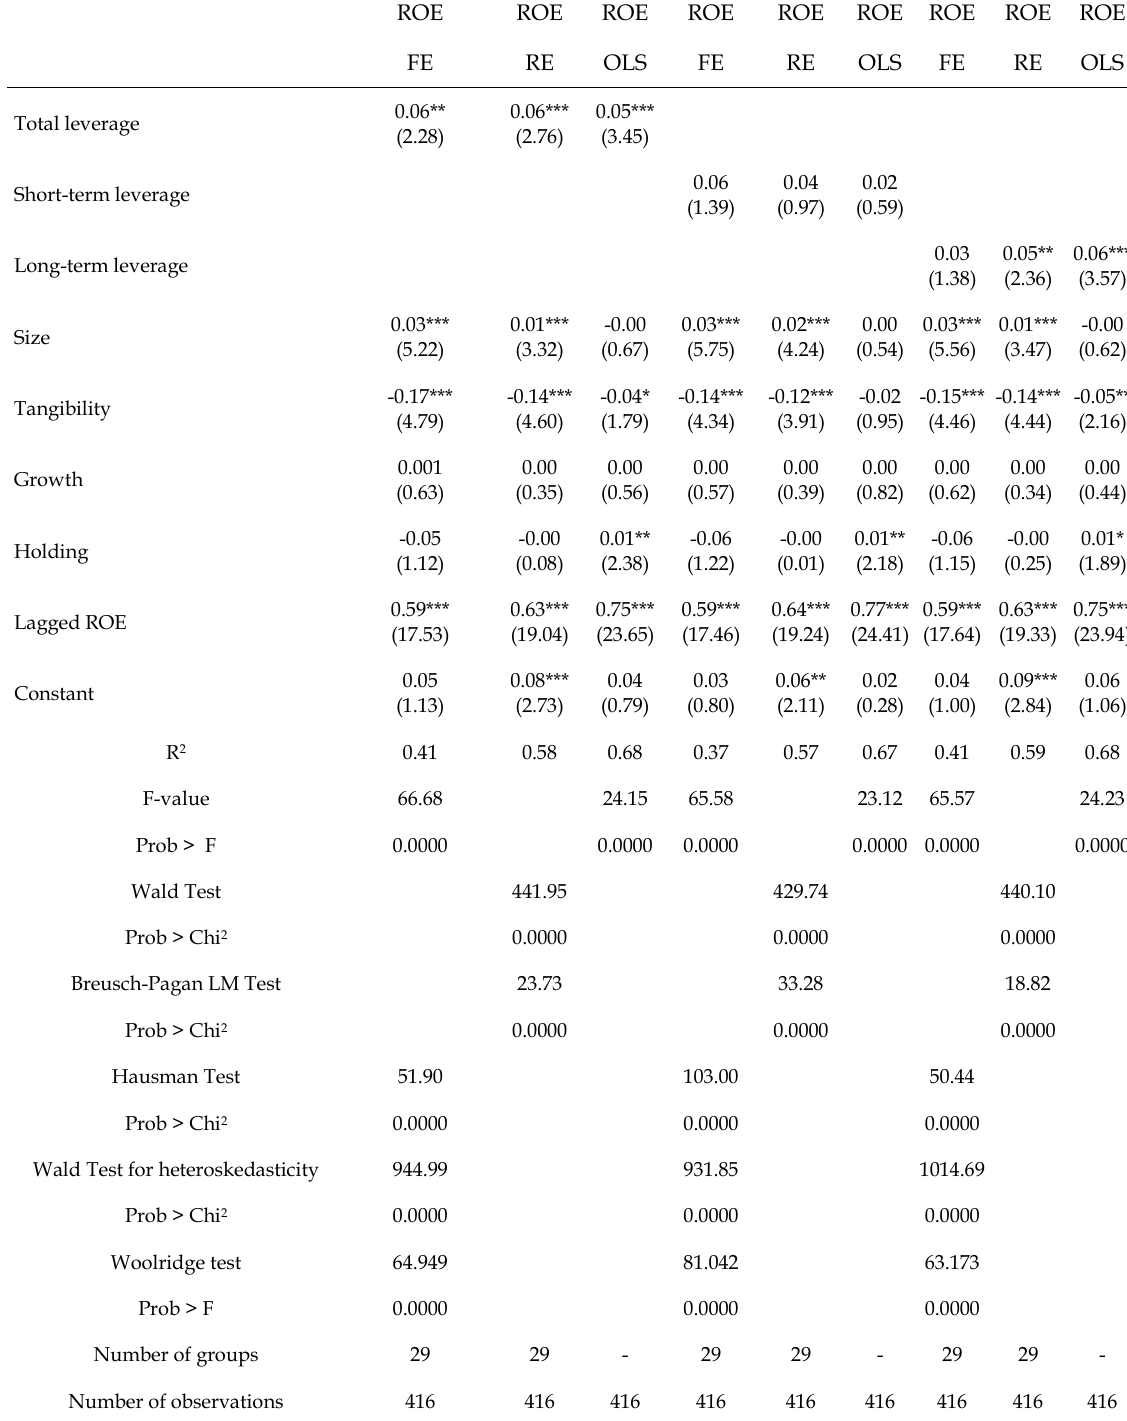
Table A2. Panel Data Estimation Results (Panel